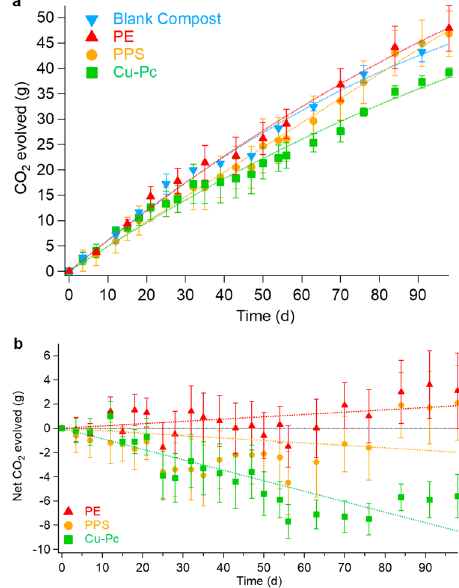
Fig. 4 Biodegradation in composting conditions of synthetic materials. a Cumulative CO 2 evolved from blank compost, PE, PPS, and Cu – Pc. b Net